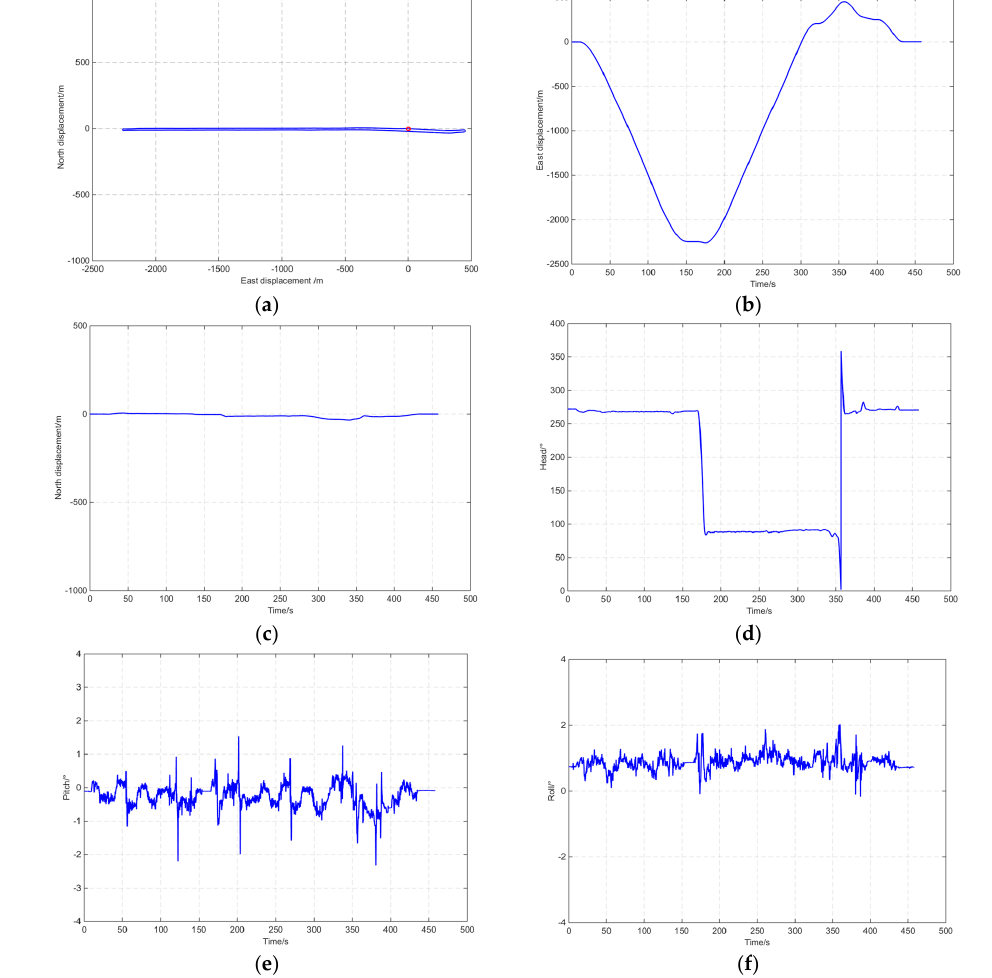
Figure 8. Reference route information measured by GI7660. ( a ) North and east displacement; ( b ) East displacement with time; ( c ) North displacement with time; ( d ) Head angle with time; ( e ) Pitch angle with time; ( f ) Roll angle with time.